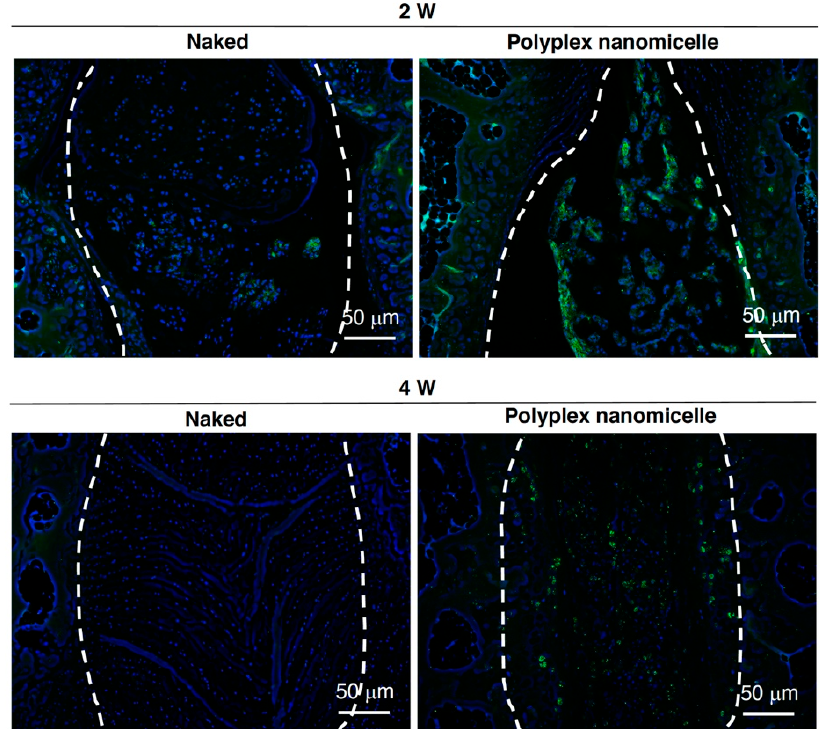
Figure 7. IHC staining examining the primary ECM composition of Type II collagen in the disc. Runx1 mRNA was injected in naked form in the punctured disc compared with that injected as Runx1 mRNA protected in polyplex nanomicelles. Representative images show the punctured disc collected at 2- and 4-weeks post-injection and IHC staining, with the first Ab recognizing Type II collagen. The second Ab was prelabeled with Alexa 488. The dashed line circles the jelly-like materials in the disc core. n = 4.